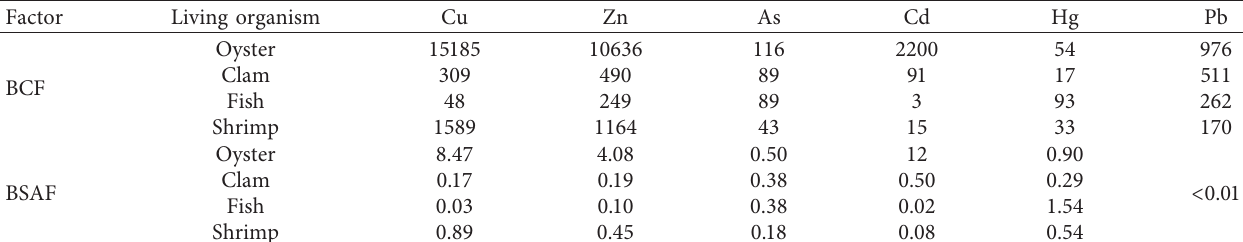
Table 13: Bioconcentration factors (BCFs) and biota-sediment accumulation factors (BSAFs) of various living organisms. Factor Living organism